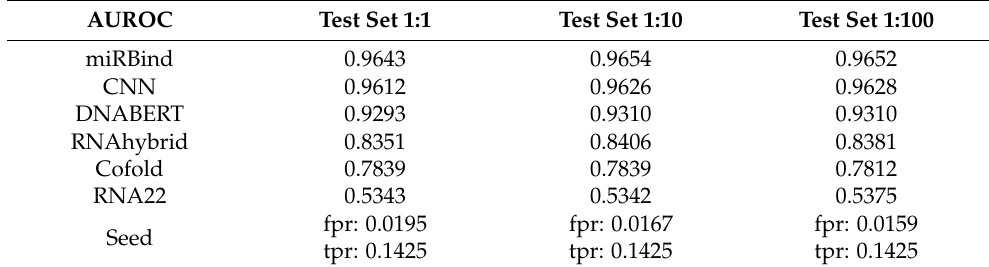
Table 3. Area under the receiver operator characteristics curve (AUROC) for the miRBind, CNN, and DNABERT models, as well as the RNAhybrid, ‘cofold’, RNA22, and ‘seed’ approaches, tested against 1:1, 1:10, and 1:100 left-out test sets. The ‘seed’ method is evaluated based on the false positive rate (fpr) and true positive rate